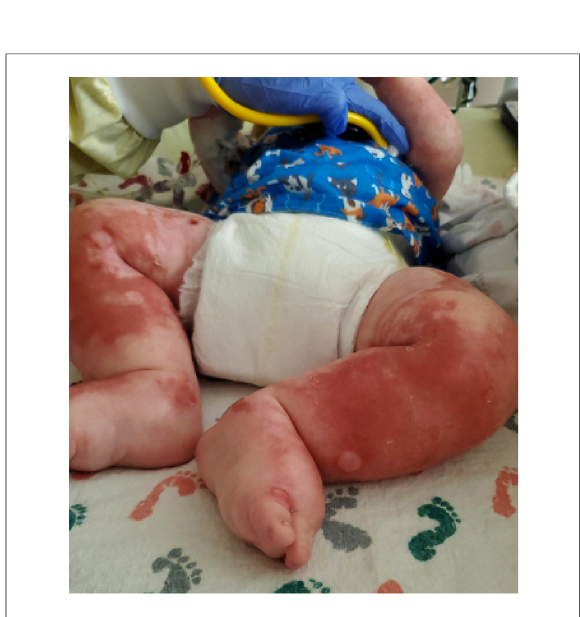
FIGURE 2 Patient ’ s lower extremities on presentation demonstrating edema and diffuse rash with scaly plaques and bullous